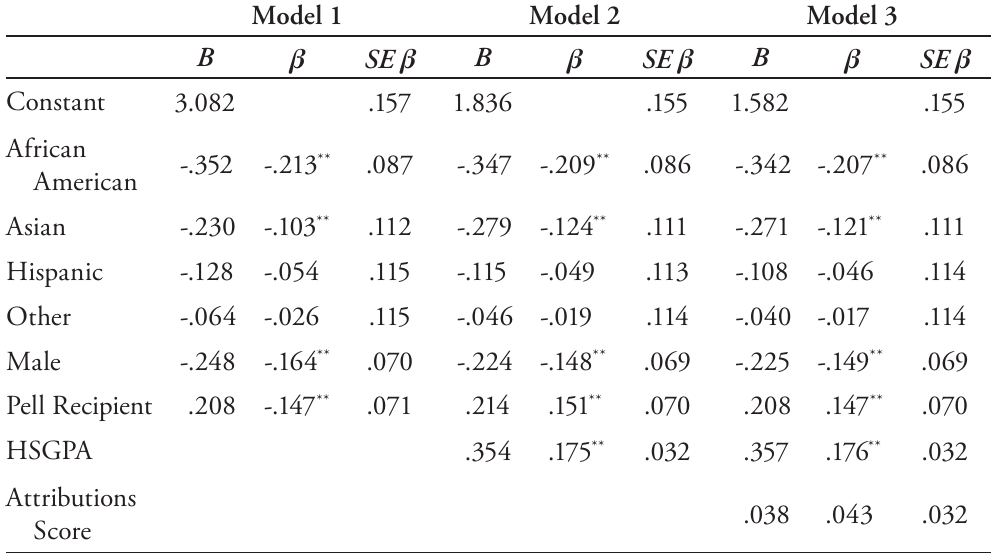
Table 5. Summary of the Hierarchical Linear Regression Predicting UGPA